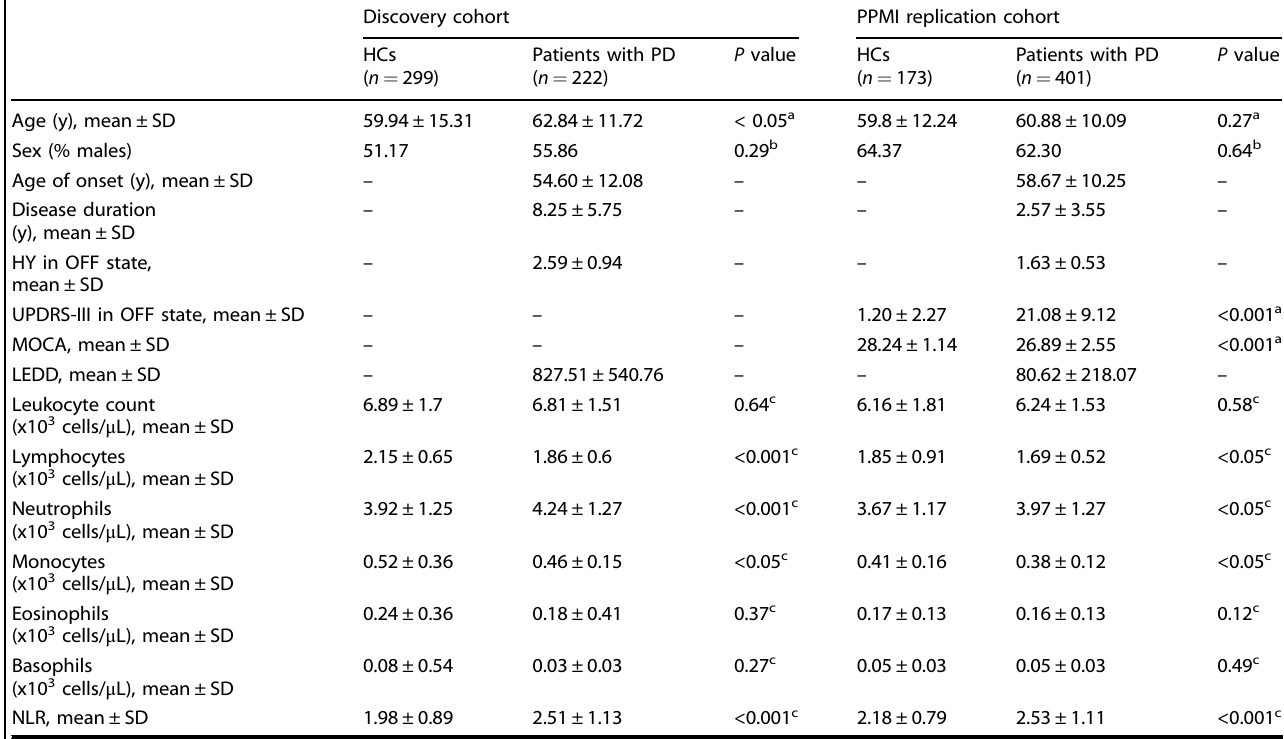
Table 1. Demographic and clinical features, as peripheral immune pro fi le of healthy controls and patients with Parkinson ’ s disease of the discovery cohort and the PPMI replication